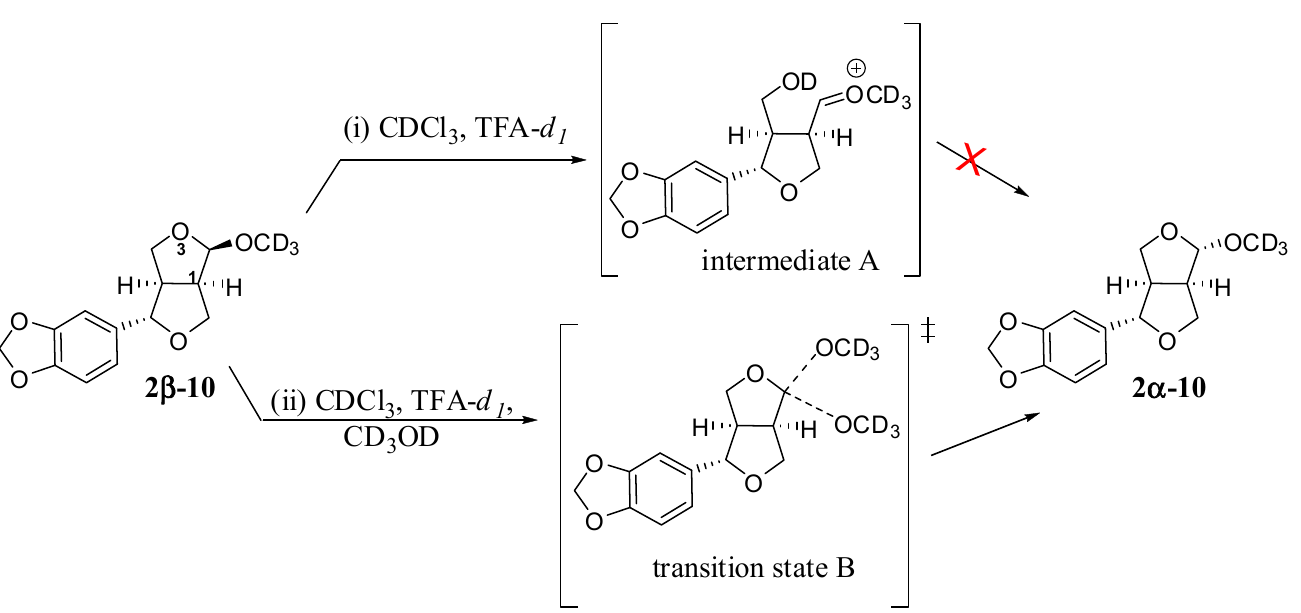
Scheme 2. Proposed transformation of 2 β -10 to 2 α -10 under different conditions.